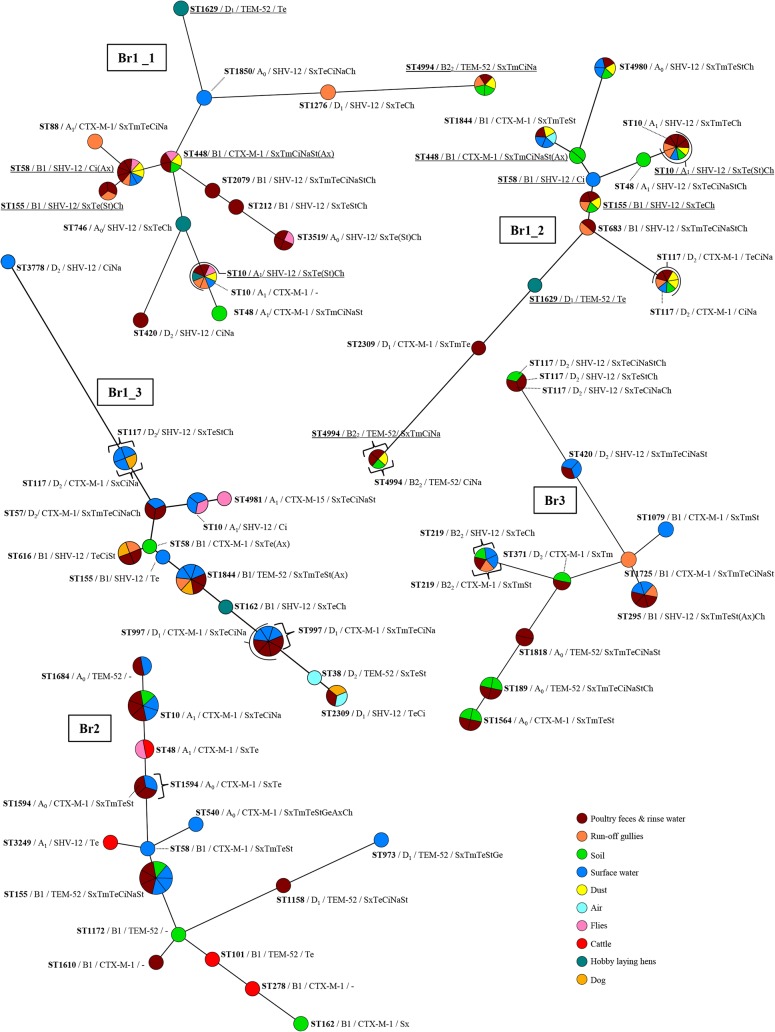
ESBL-producing E. coli variants on broiler farms.Maximum parsimony trees constructed based on the concatenated sequences of the seven MLST alleles, using Bionumerics 7.1 software. Node sizes reflect the number of isolates per ST and node colours represent different matrices. Additionally indicated are the phylogenetic group, ESBL-genotype and ABR profiles of isolates in every node (i.e., ST). Note that per sample maximally one isolate of each variant was included, and that multiple isolates of a specific variant reflects detection in multiple samples. ABR profiles represent antibiotics to which resistance was observed additionally to 3rd generation cephalosporins. In between brackets are antibiotics with MICs just above and just below epidemiological cut-off values (i.e. with a maximal 2-fold difference) among isolates with the same ST and/or ESBL genotype. Sx = sulfamethoxazole, Tm = trimethoprim; Te = tetracycline, Ci = ciprofloxacin, Na = nalidixic acid, St = streptomycin, Ge = gentamycin, Ax = amoxicillin+clavulanic acid, Ch = chloramphenicol. Br1 was sampled during three production rounds: August/September 2011 (Br1_1), November 2011 (Br1_2), and August/September 2012 (Br1_3); underlined are variants that were detected at multiple time-points.